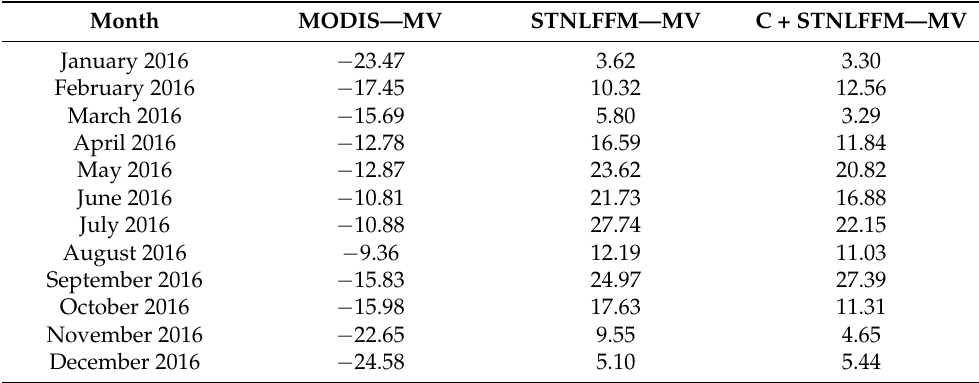
RE and MV represent Relative Error and Measured Value,